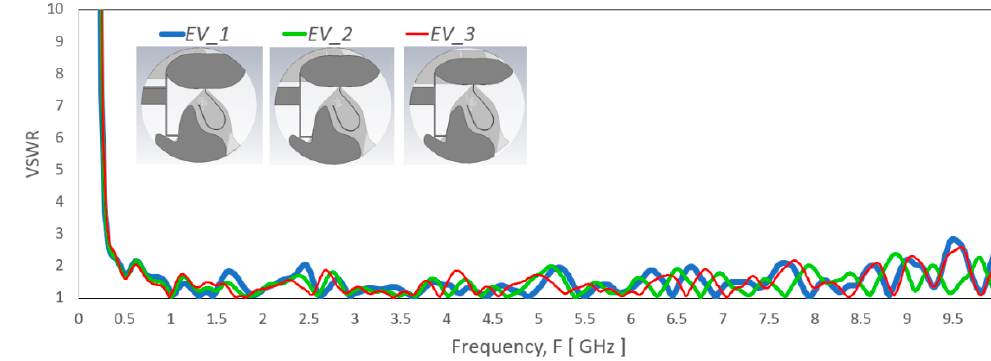
Figure 16. VSWR of the antenna with a different set of spline points ( EV_1 , EV_2 and EV_3 that construct the monopole elliptical-liked radiator patch. PatchPoints1 to PatchPoints7 defines the set of spline points in ( EV_1 , EV_2 and EV_3 ) that related to PatchW .